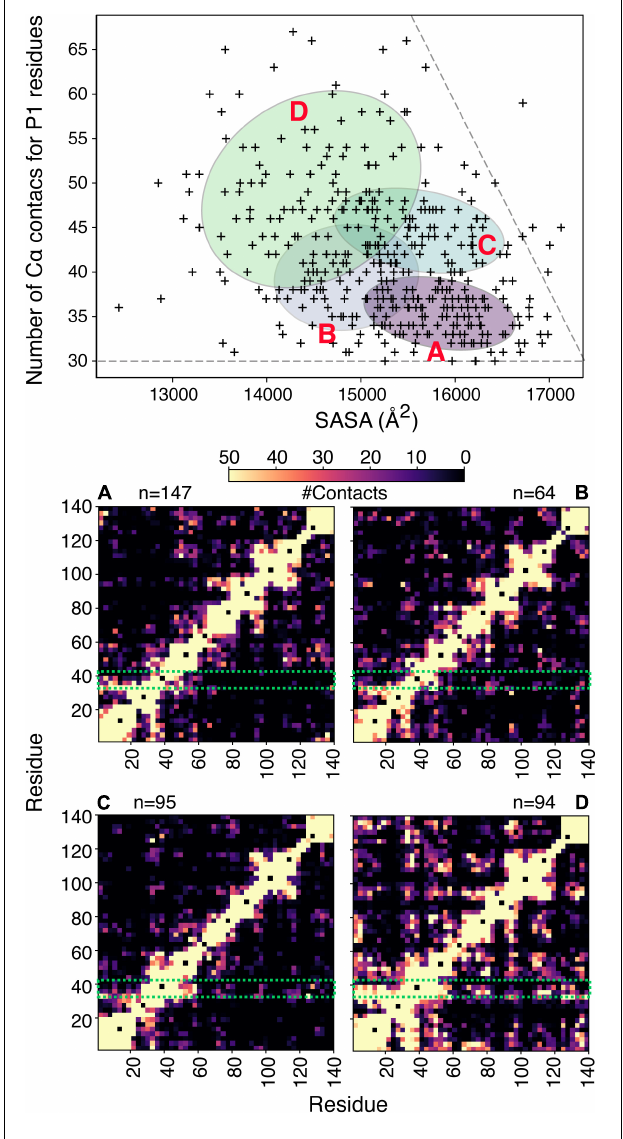
FIGURE 4 | Clustering of α Syn conformers based on aggregation-prone regions. (A) Bayesian Gaussian mixture model to classify an α Syn ensemble (Allison et al., 2009) that consists of 400 structures shown in Figure 3 , based on the number of C α contacts made by residues in P1 and the solvent accessible surface area. For clustering a contact is defined if two C α atoms are within 8 Å. The four ellipses correspond to the four clusters identified and are labeled (A–D) . The corresponding contact maps are shown below. For the contact maps the definition of contacts is more generous and includes all atoms of two given residues. The P1 region is highlighted in a green box and n denotes the number of structures in each cluster.